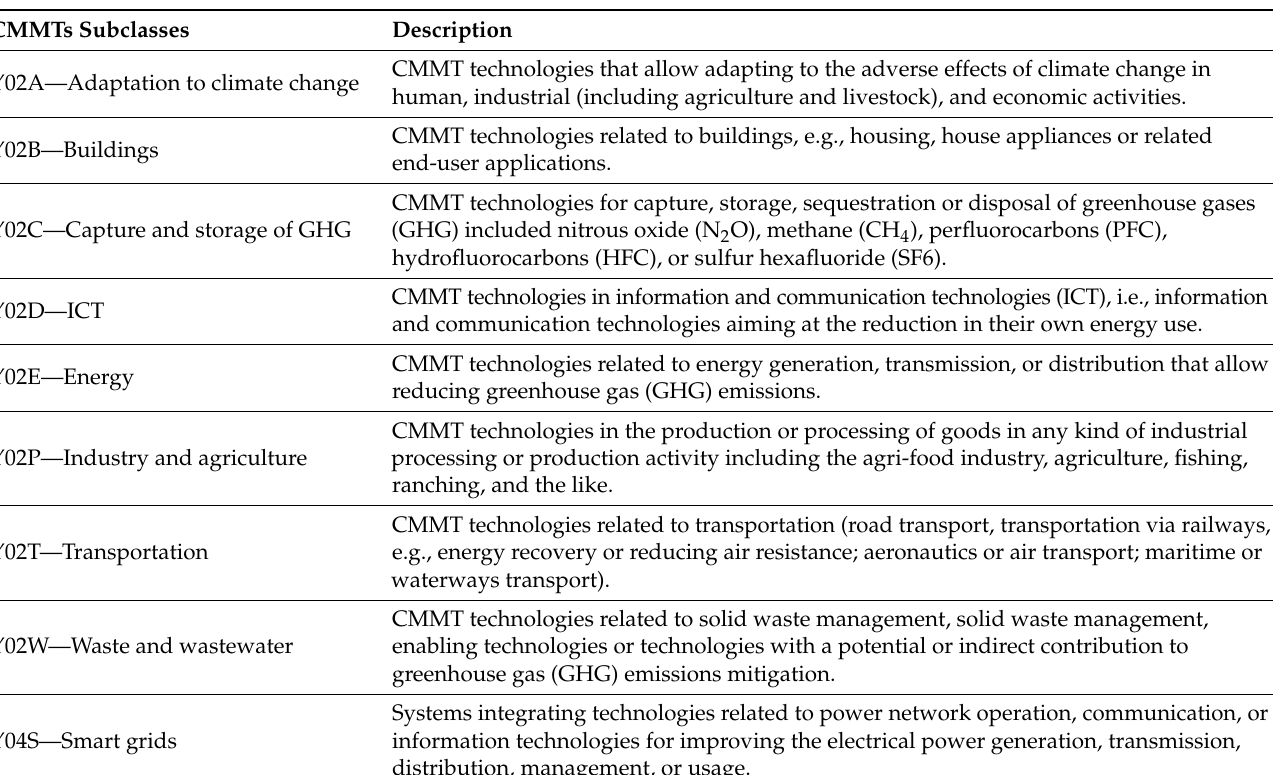
Table 1. Climate change mitigation technology